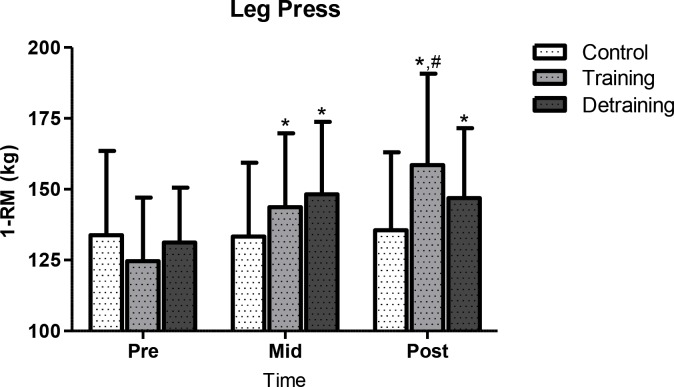
1RM changes during the experimental period.1RM, one repetition maximum; *significant difference with baseline (p<0.05); #significant difference with previous time point (p<0.05).